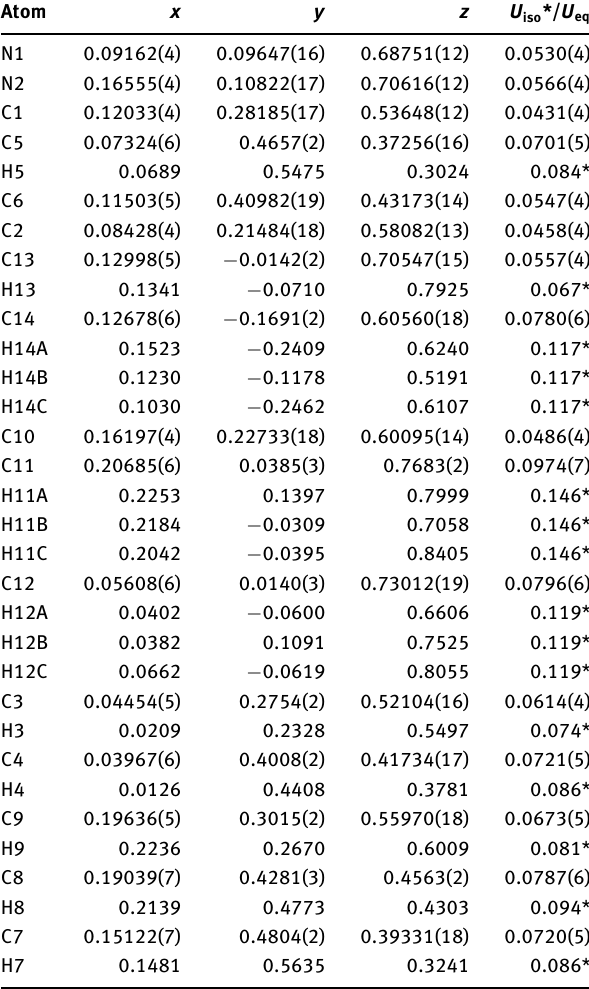
Table 2: Fractional atomic coordinates and isotropic or equivalent isotropic displacement parameters (Å 2